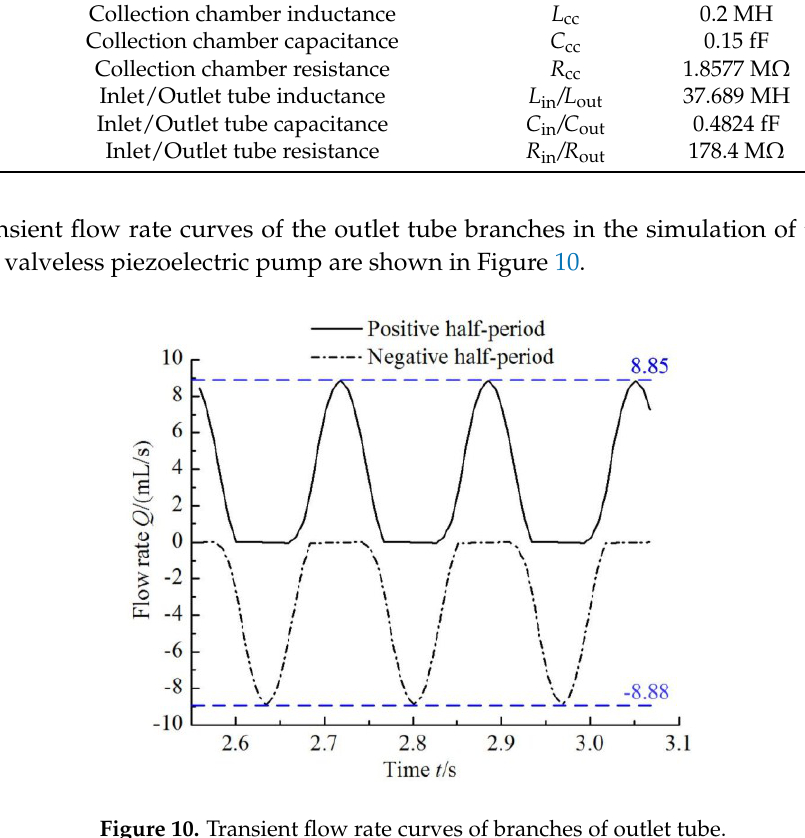
Table 2. Calculation results for equivalent circuit components.